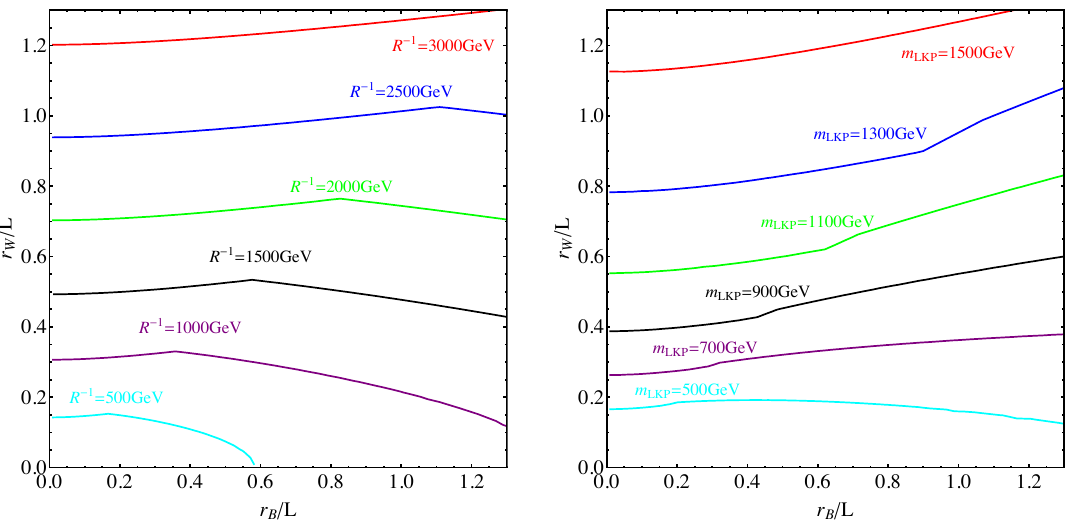
Figure 4 . Bounds on R (cid:0) 1 from four-Fermi contact interactions in r B =L and r W =L space. Left: contours of minimally allowed values of R (cid:0) 1 . Right: contours of minimally allowed values of m LKP . and eedd . We draw the contours for various values of R (cid:0) 1 2 (500 ; 3000) GeV (left) and the LKP mass, m LKP 2 (500 ; 1500) GeV (right). The region above the line with a